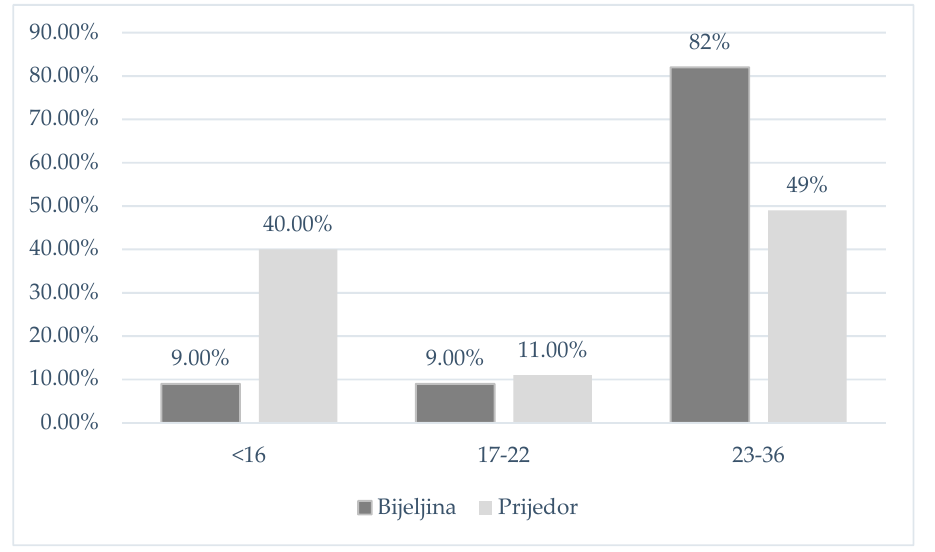
Figure 1. Levels of health literacy by town.